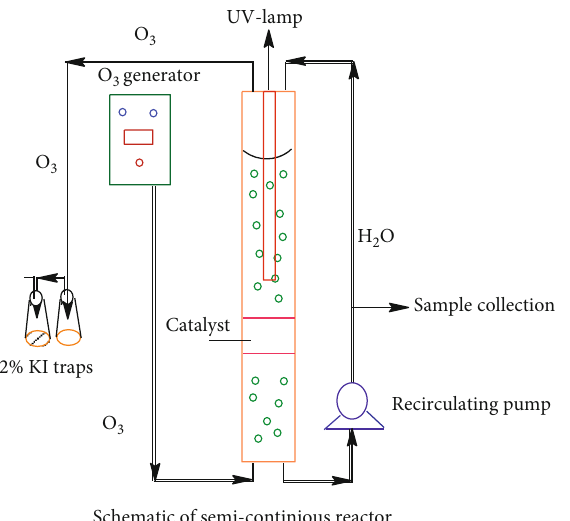
Figure 1: Schematic of semicontinuous reactor for the treatment of cipro fl oxacin by the catalytic ozonation process.